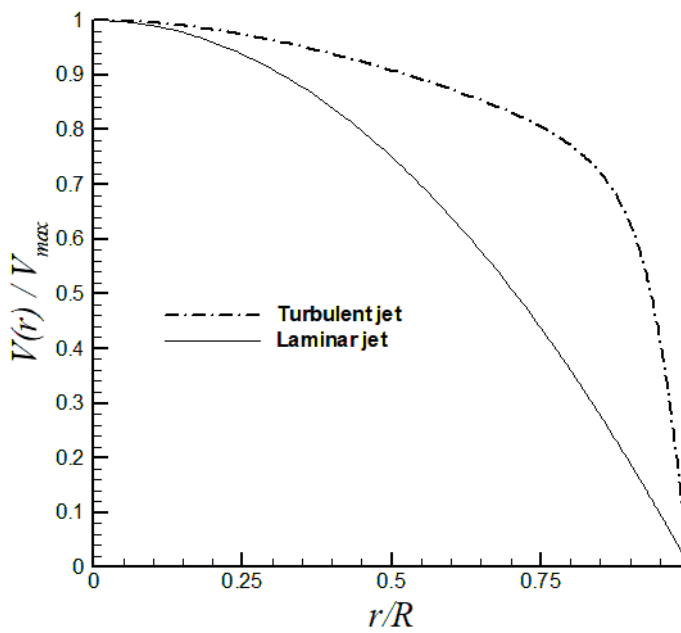
Figure 3. Wall-normal velocity distribution prescribed at the jet location.